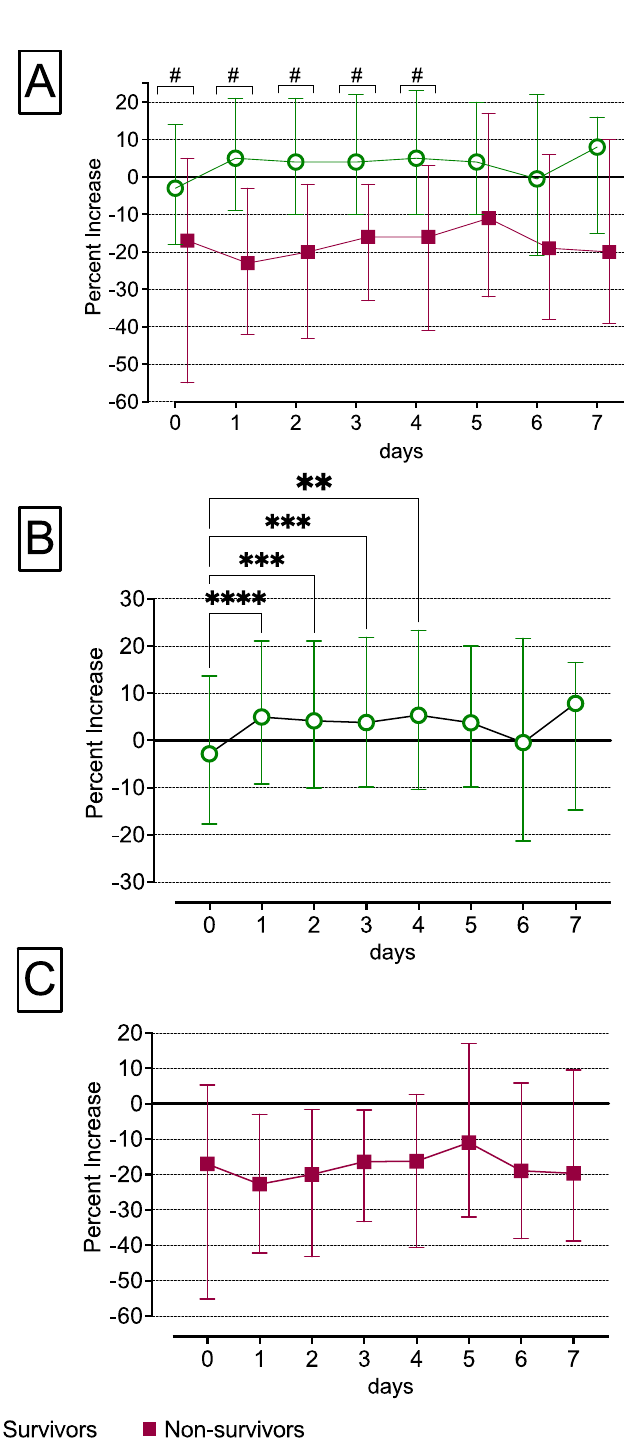
Figure 1. Missing transition from the early to the late period in non-survivors. In patients who survived, the REE significantly increased during the transition from the early to the late period. In contrast, the REE did not increase during the transition from the early to the late period in non-survivors, as depicted in ( A ). In survivors, there was a statistically significant percent increase in the REE from day 0 to day 1, day 2, day 3 and day 4, as depicted in ( B ). In contrast, in non-survivors, the REE did not increase during the transition from the early to the late period, as shown in ( C ). Percent increase = (REE meas − REE pred)/REE pred × 100; REE pred = 20 × kcal/kg/day; meas, measured; pred, predicted; REE, resting energy expenditure; ** p < 0.001, *** p < 0.0001, **** p < 0.00001; # p < 0.05.